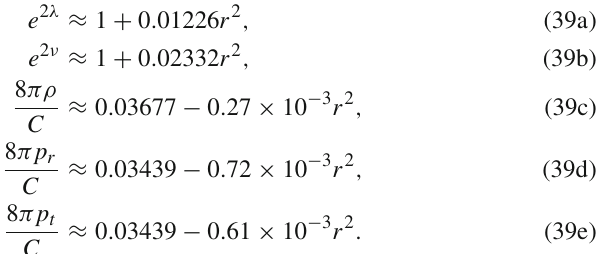
1785, Cen X-3, 4U1820-30, PSR J1903+327, Vela X-1